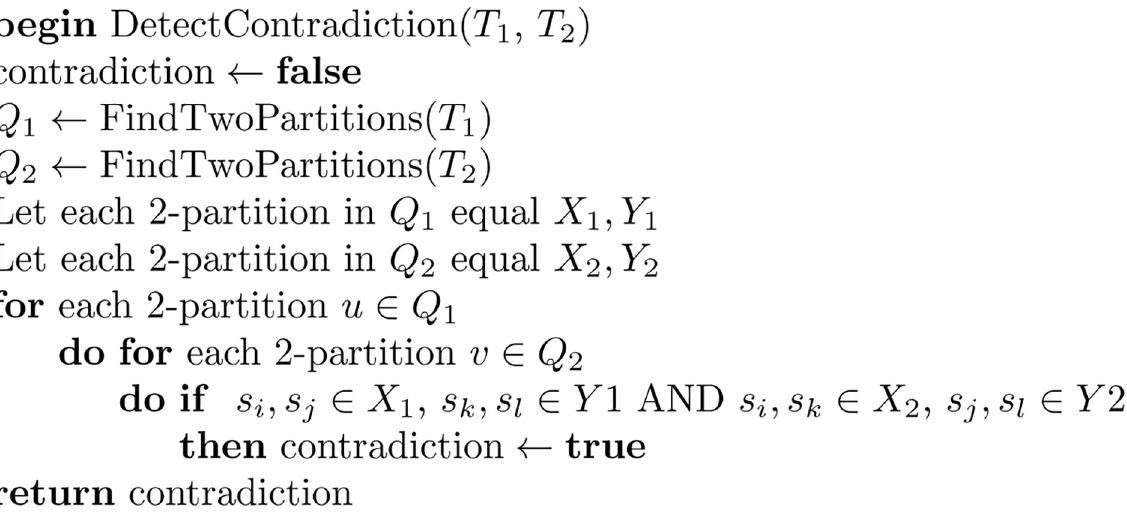
Fig 32. Algorithm to detect contradiction between two trees.